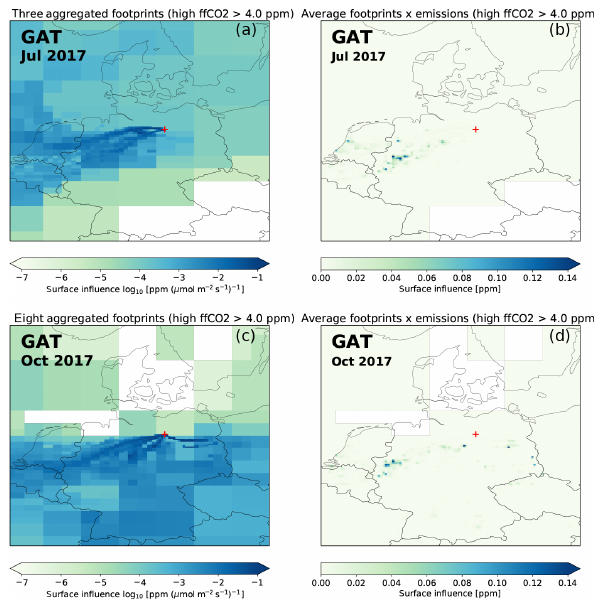
Figure 9. Aggregated footprints with elevated ffCO 2 , and the cor- responding surface influences for Gartow in July 2017 (a–b) and October 2017 (c–d) , based on the EDGAR version 4.3.2 emission inventory. Note the logarithmic colour scale in the aggregated foot- print maps.